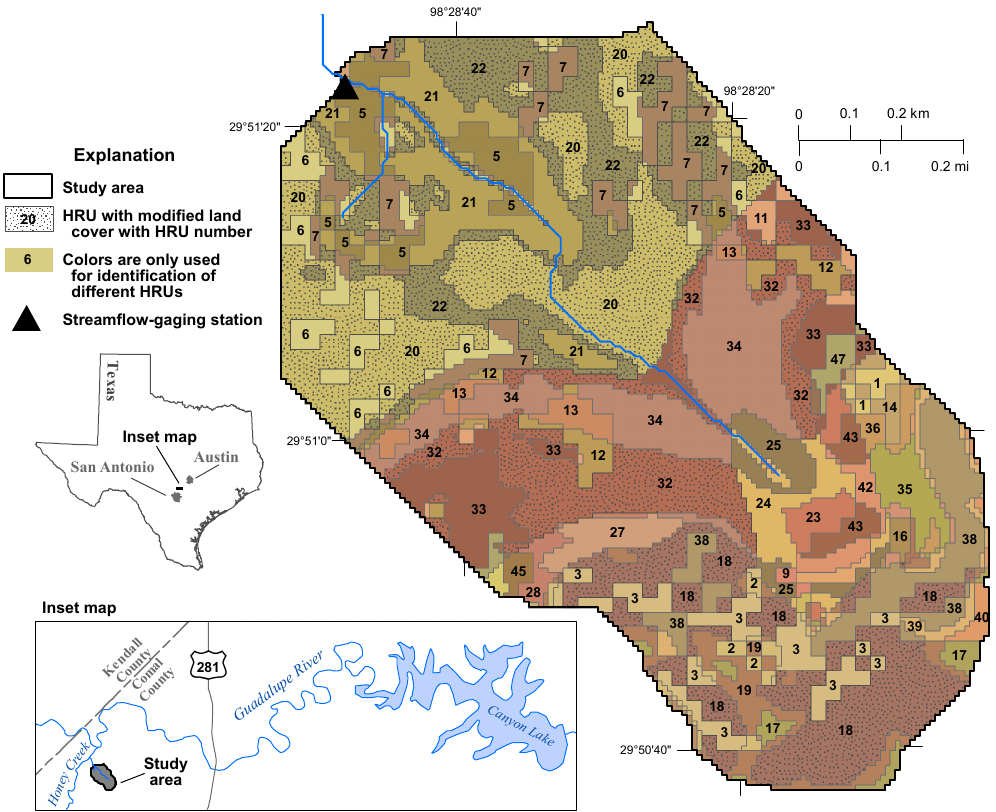
Figure 1. Study area and watershed location. The 47 HRUs yielded by the ArcSWAT tool (Winchell et al., 2007). The model inputs of HRUs 18, 20, 22, and 32 (stippled pattern) were modified to simulate the brush-management activities. Streamflow-gaging station (US Geological Survey streamflow-gaging station 08167353) is on an unnamed stream. Base map from US Geological Survey digital data, 1:24000 Universal Transverse Mercator projection, Zone 15 North American Datum of